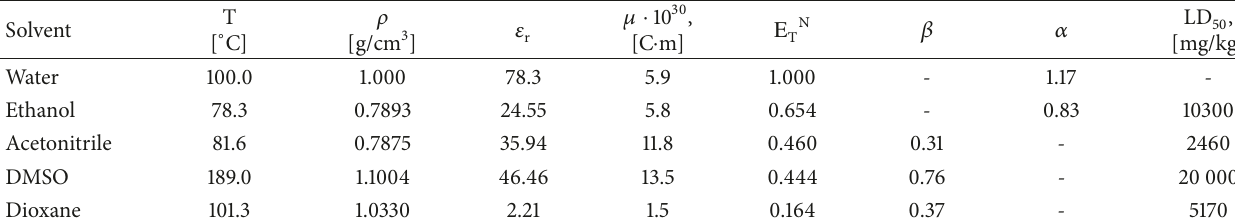
Table 1: Physical properties ∗ of the solvents used and their toxicity.